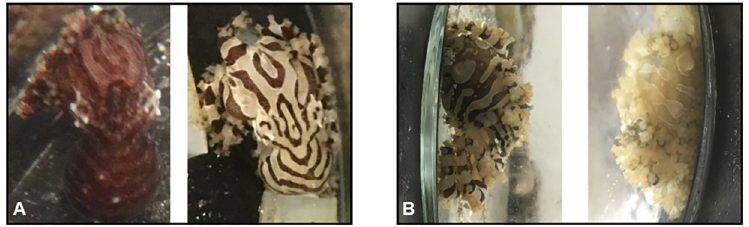
Fig 2. Visibility of O . chierchiae stripe configuration during different body color morphs. (A) O . chierchiae displaying dark morph (left) and stripe-bar-spot morph (right) illustrating how chromatophores activate directly over the leucophores to mask their whiteness. (B) A different O . chierchiae displaying stripe-bar-spot morph (left) and pale morph (right) illustrating how chromatophores expand adjacent to leucophore white markings to produce high- contrast